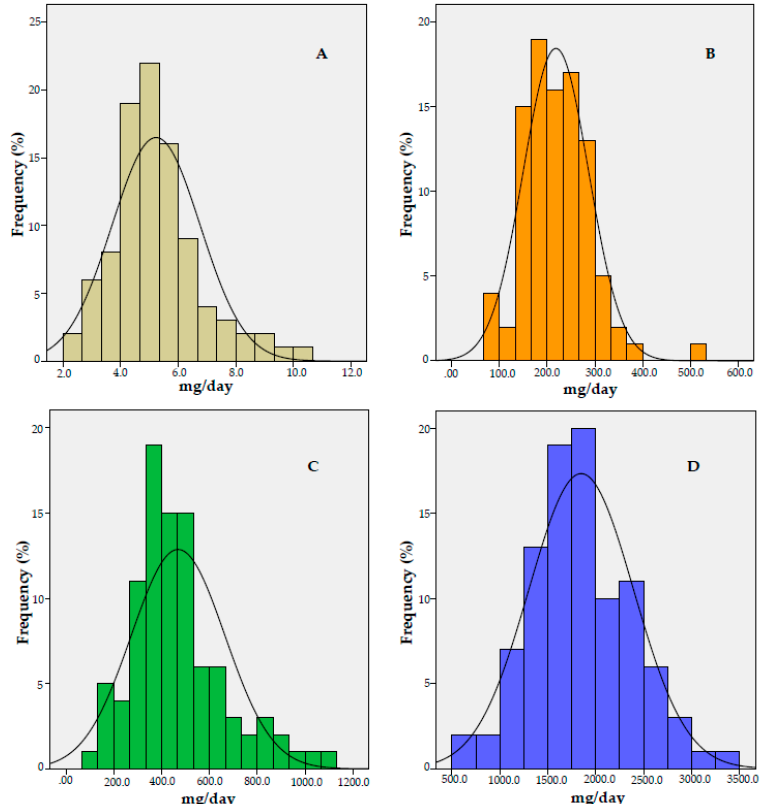
Figure 1. Histogram of energy-adjusted intake of zinc ( A ), magnesium ( B ), calcium ( C ), and potassium ( D ), and prevalence of inadequate intake in individuals with type 2 diabetes mellitus (T2DM) ( n =